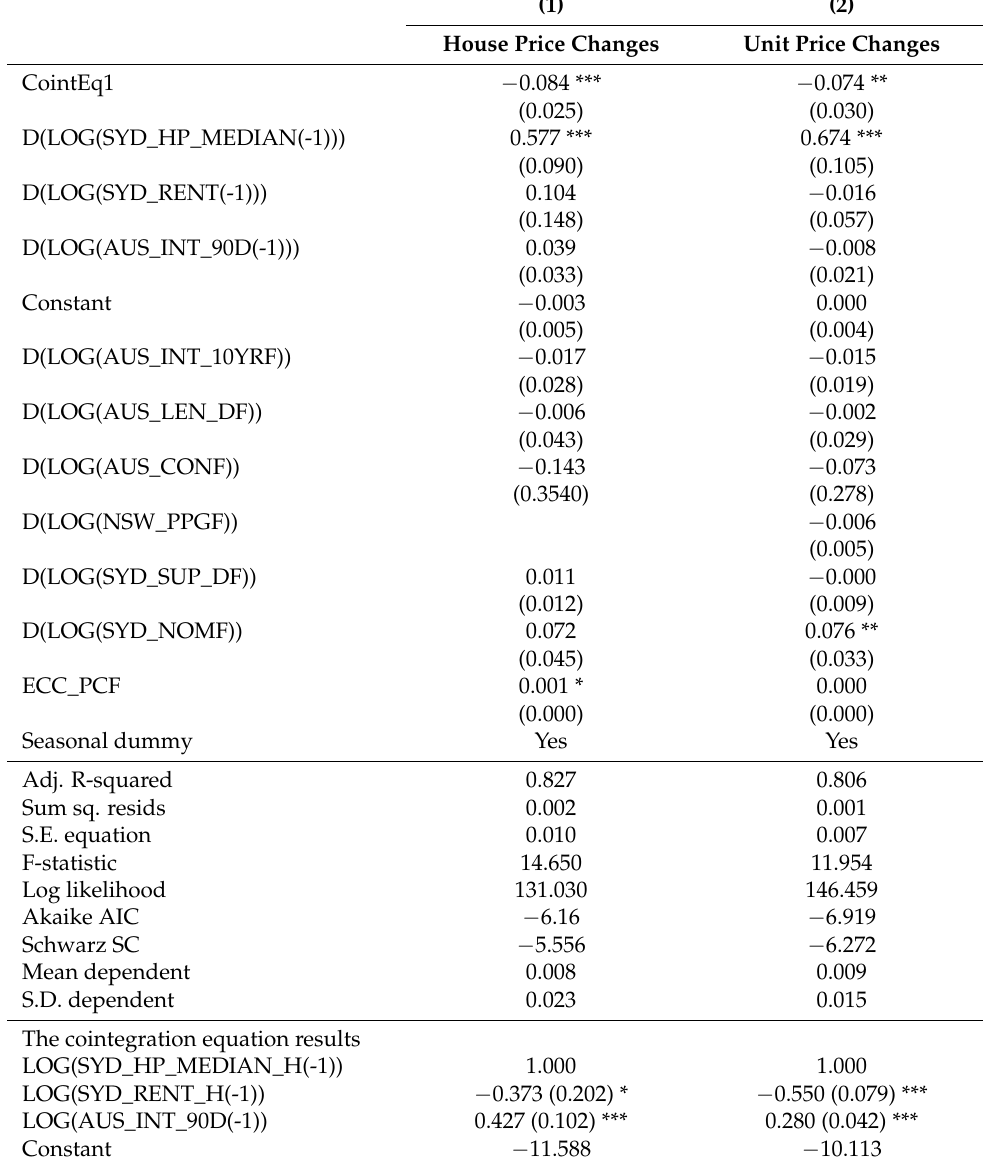
Table A1. Error Correction Model Estimates for the Period between Q3 2004 and Q4